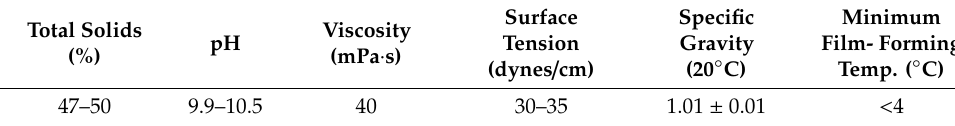
Table 2. Properties of SBR latex.